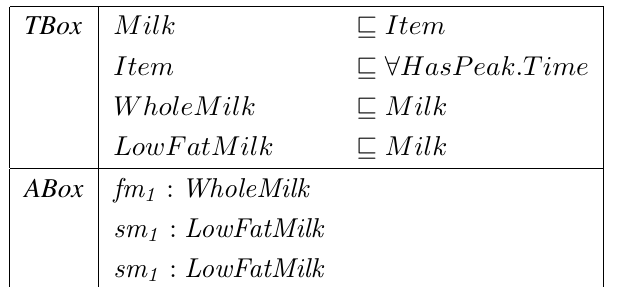
Figure 6. Domain knowledge sample for milk monitoring.